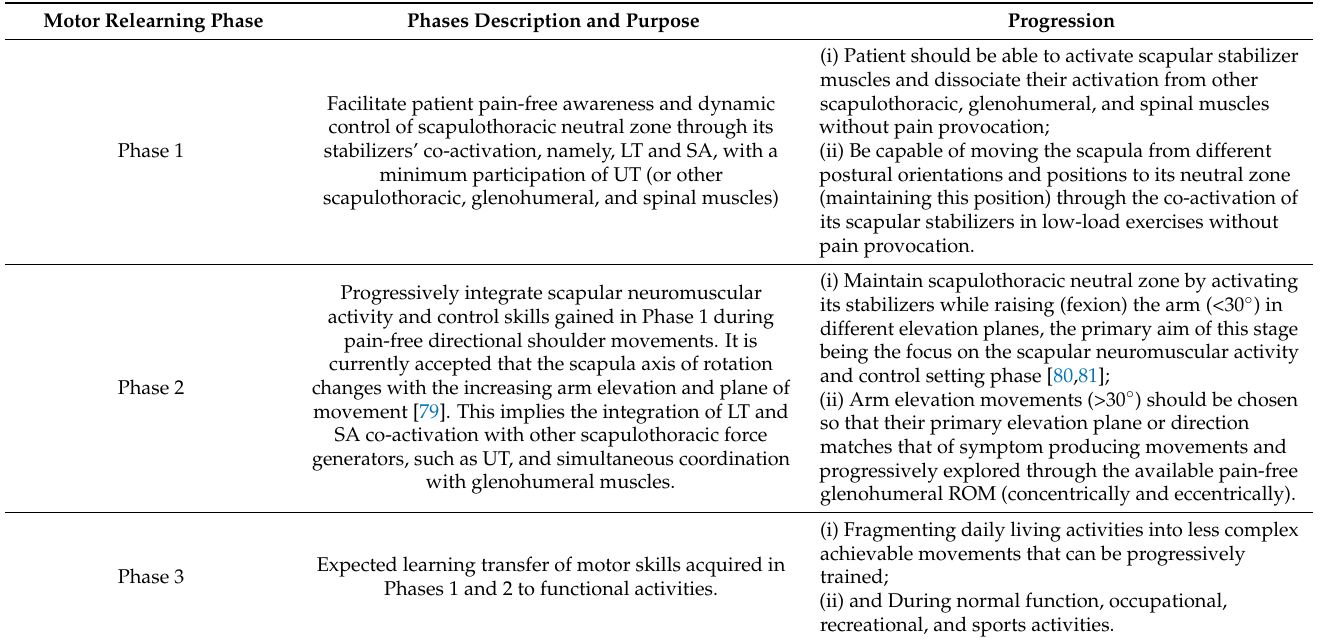
Table A2. Motor relearning phases of the treatment